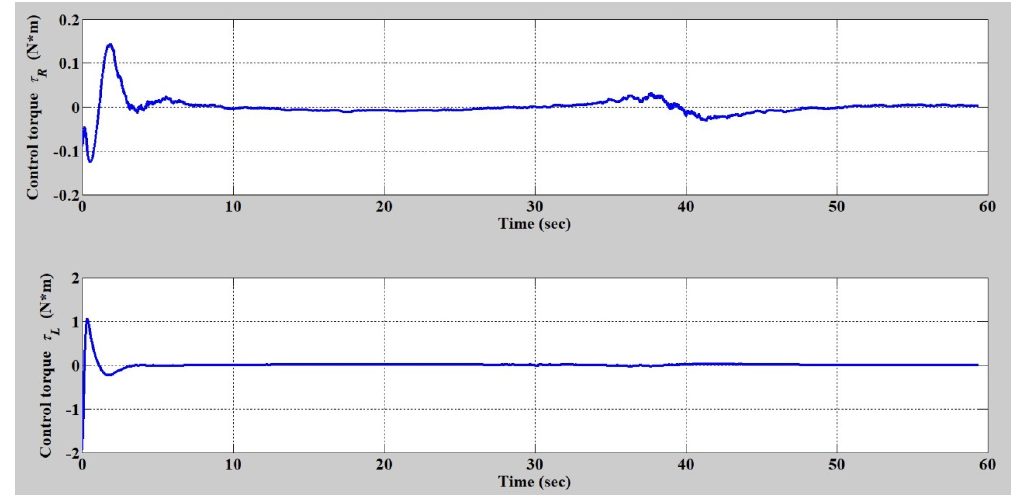
Figure 15. Results of S-type trajectory tracking errors concerning initial point ( x c = 0 m, y c = − 1.9 m).